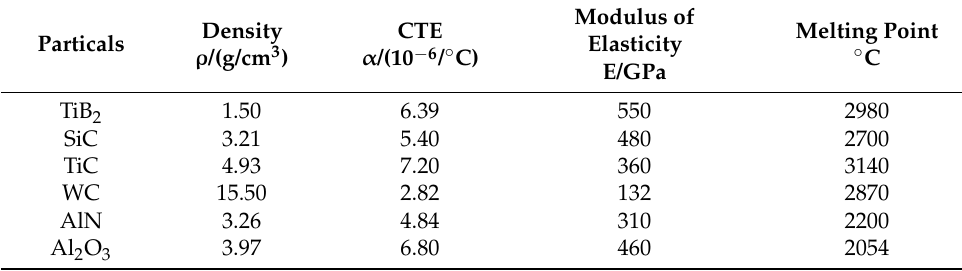
Table 2. The properties of common reinforcements